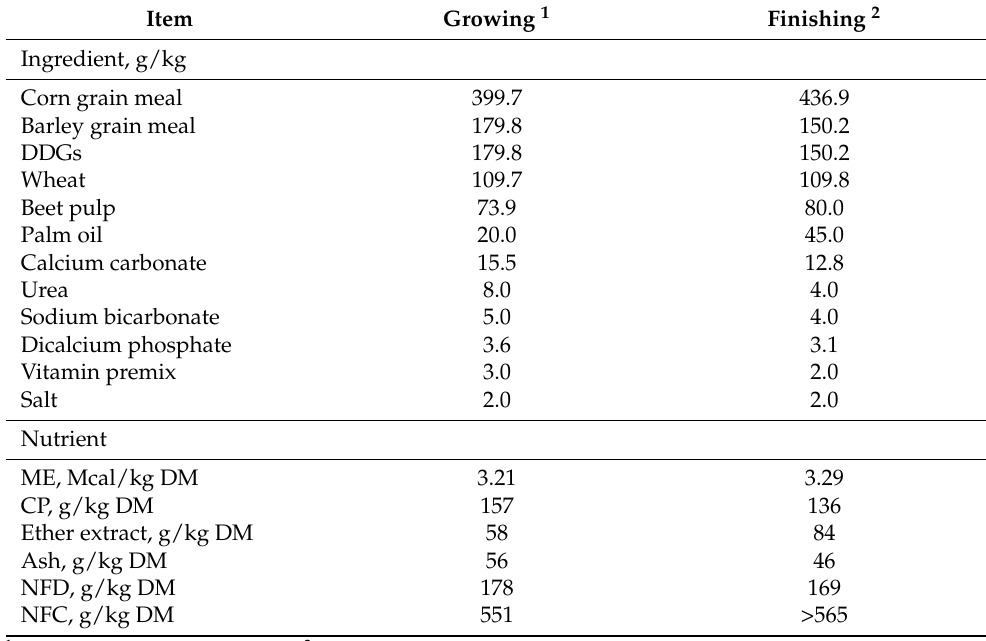
Table 1. Ingredient and nutrient composition of the dietary